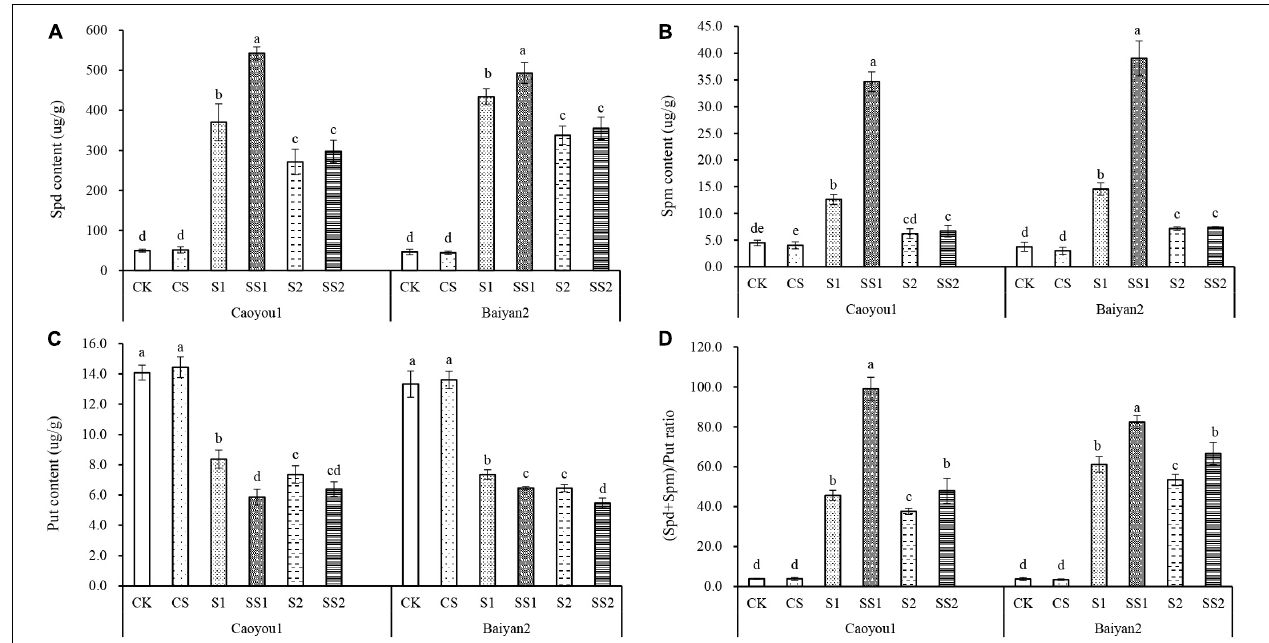
FIGURE 6 | Effects of Spd application on endogenous Spd (A) , Spm (B) , and Put content (C) , and (Spd + Spm)/Put ratio (D) under salt stress in the oat seedlings. CK, Nutrient solution + distilled water; CS, Nutrient solution + 0.75 mM Spd; S1, 70 mM salt + distilled water; SS1, 70 mM salt + 0.75 mmol/L Spd; S2, 100 mM